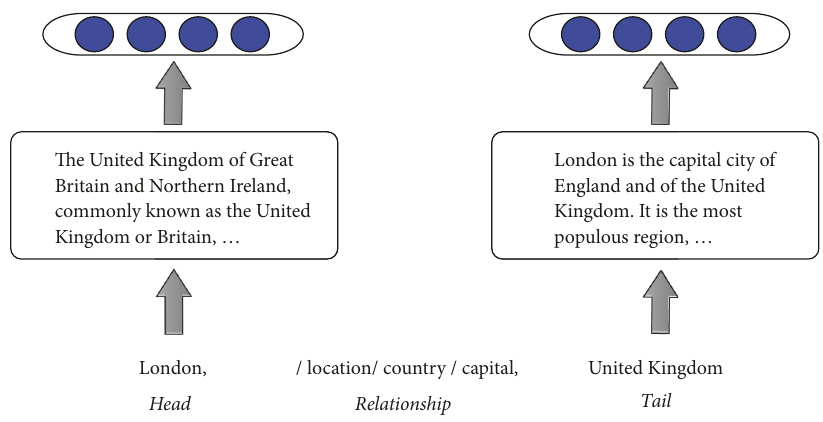
Figure 4: Text description of the